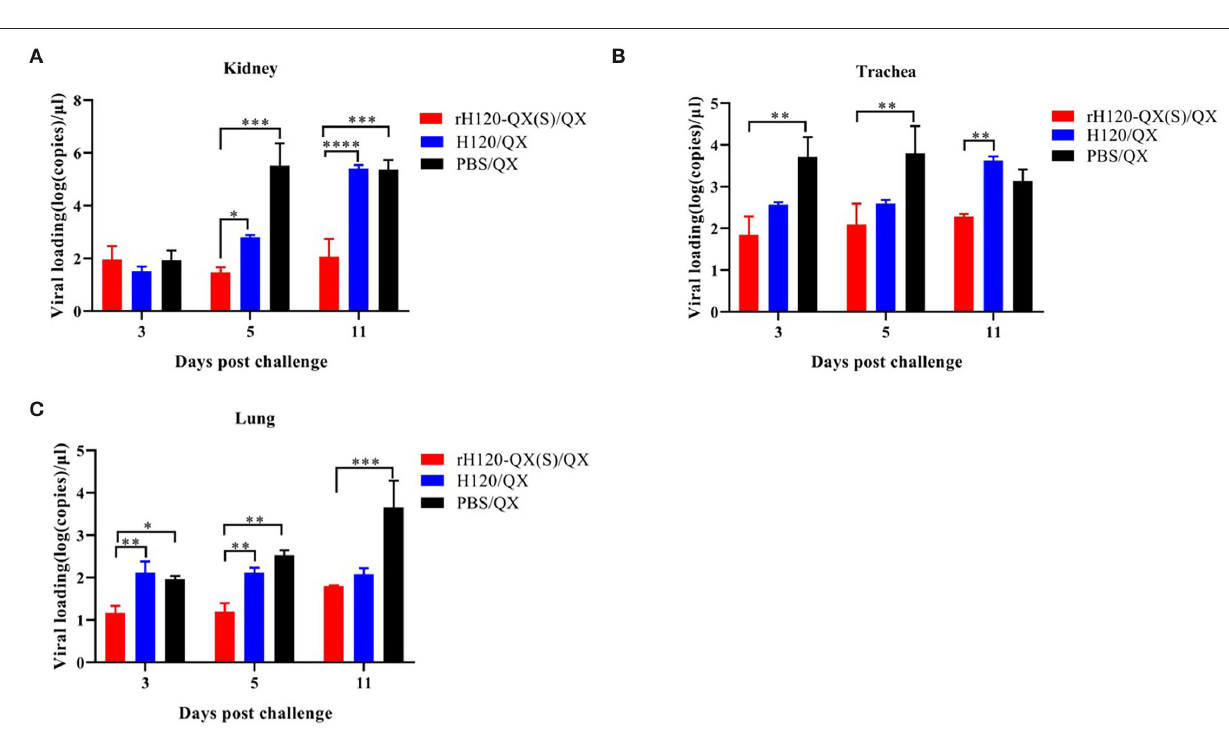
FIGURE 6 | QX virus load in the kidney, trachea, or lung of SPF chickens vaccinated with rH120-QX(S), H120, or treated with PBS, followed by QX challenge. (A) QX virus load in the kidney on 3, 5, and 11 d.p.c. (B) QX virus load in the trachea on 3, 5, and 11 d.p.c. (C) QX virus load in the lung on 3, 5, and 11 d.p.c. * p ≤ 0.05; ** p ≤ 0.01; *** p ≤ 0.001; **** p ≤